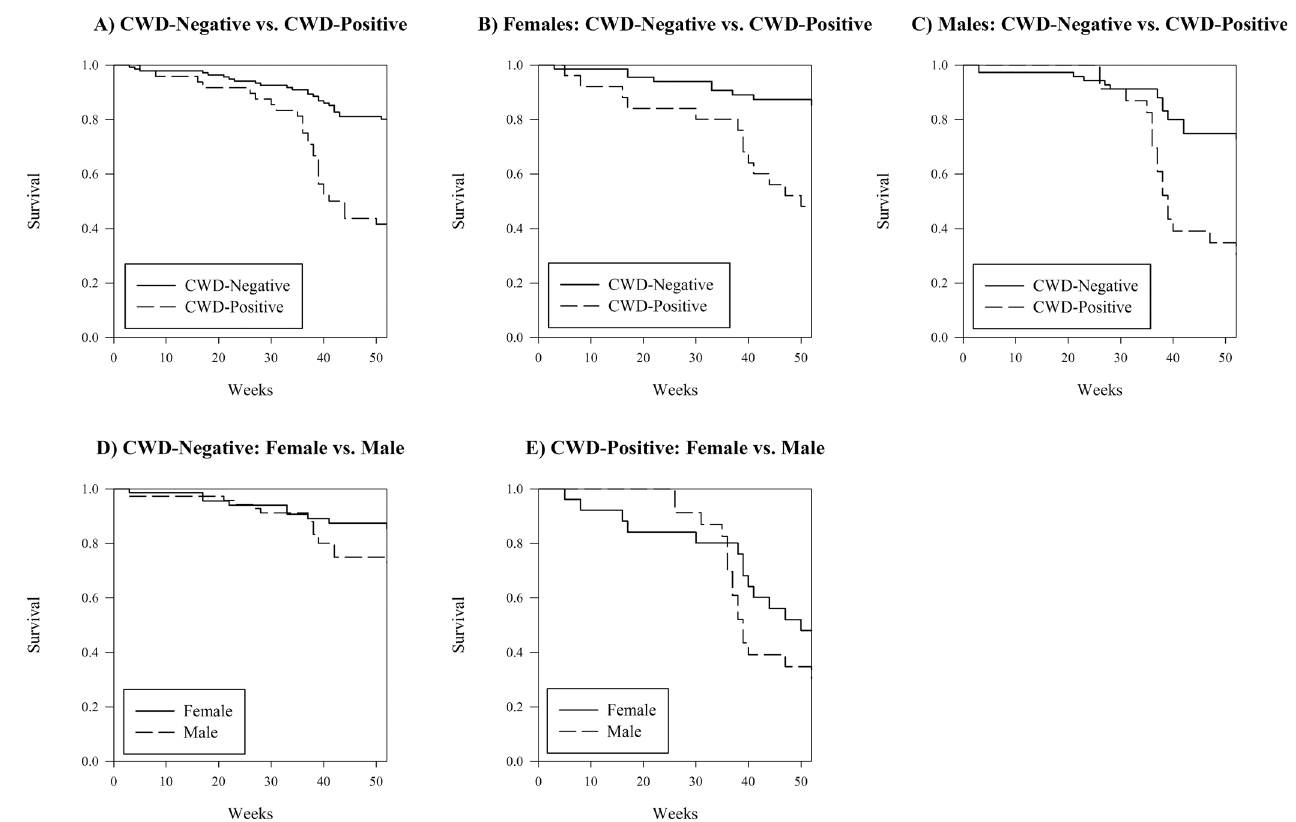
Fig 2. Kaplan-Meier Annual Survival Rate Curves. Survival rate curves of segments of the white-tailed deer study population that was captured, tested for CWD by tonsil biopsy, marked with radio transmitters, and followed by radio telemetry SW of Glenrock, WY (2003 – 2010).